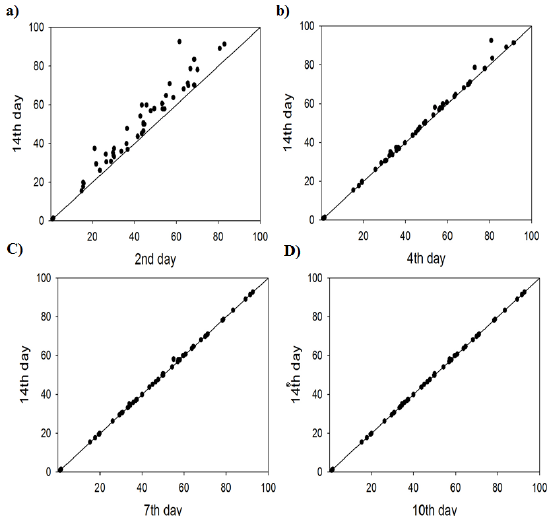
Fig. 3. Percent of germinated seeds are shown for different days (2 nd (a), 4 th (b), 7 th (c), and 10 th (d)) after exposure to the condition of germinating in darkness against 14 th by line 1:1. The last day for counting was considered the 14 th day according to the HSDT method.